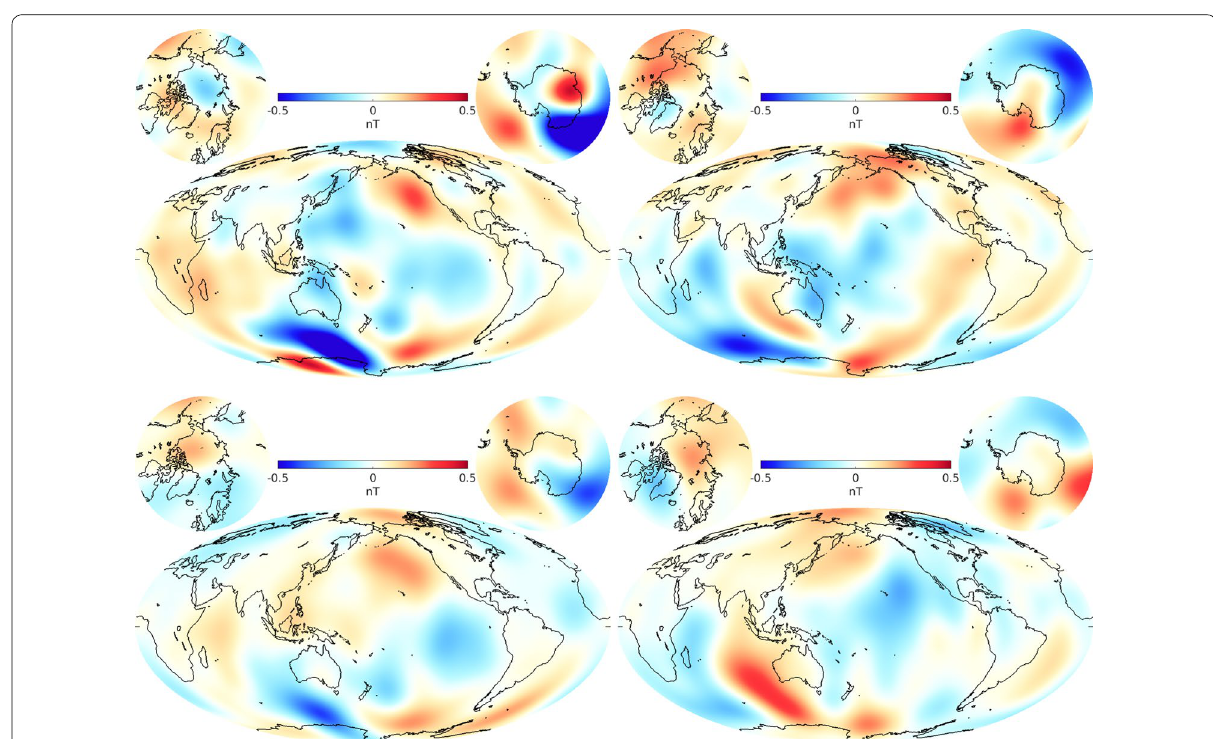
1 12 at satellite = −